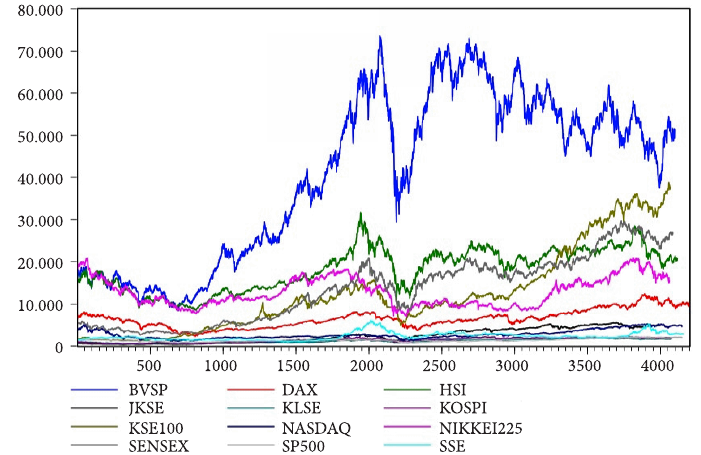
Fig. 1. Historical time series graph (source: authors’